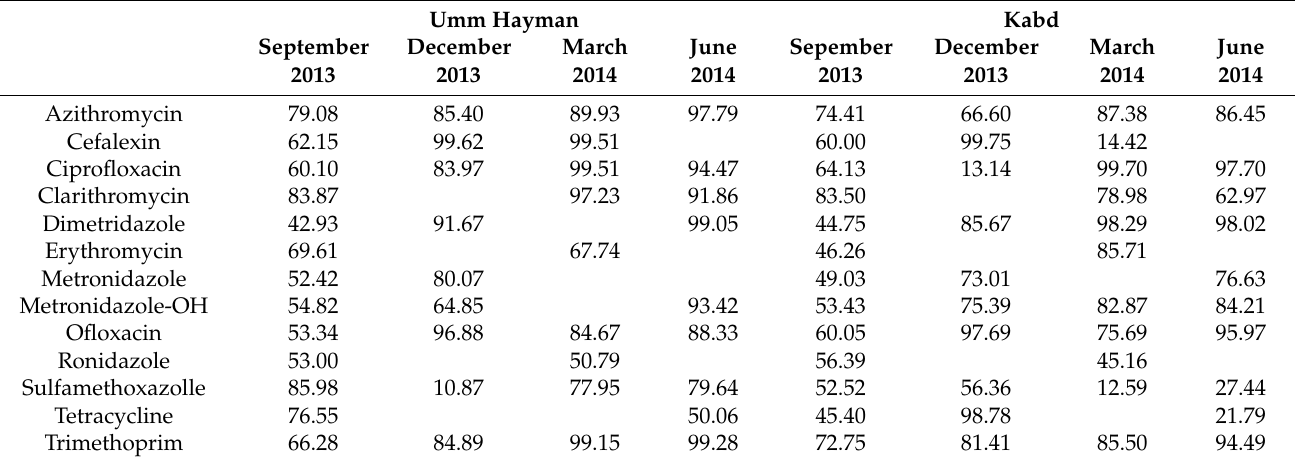
Table 5. Removal efficiencies of antibiotics, expressed as percentages, during wastewater treatment over the four sampling campaigns at Kabd and Umm Hayman WWTPs. Umm Hayman